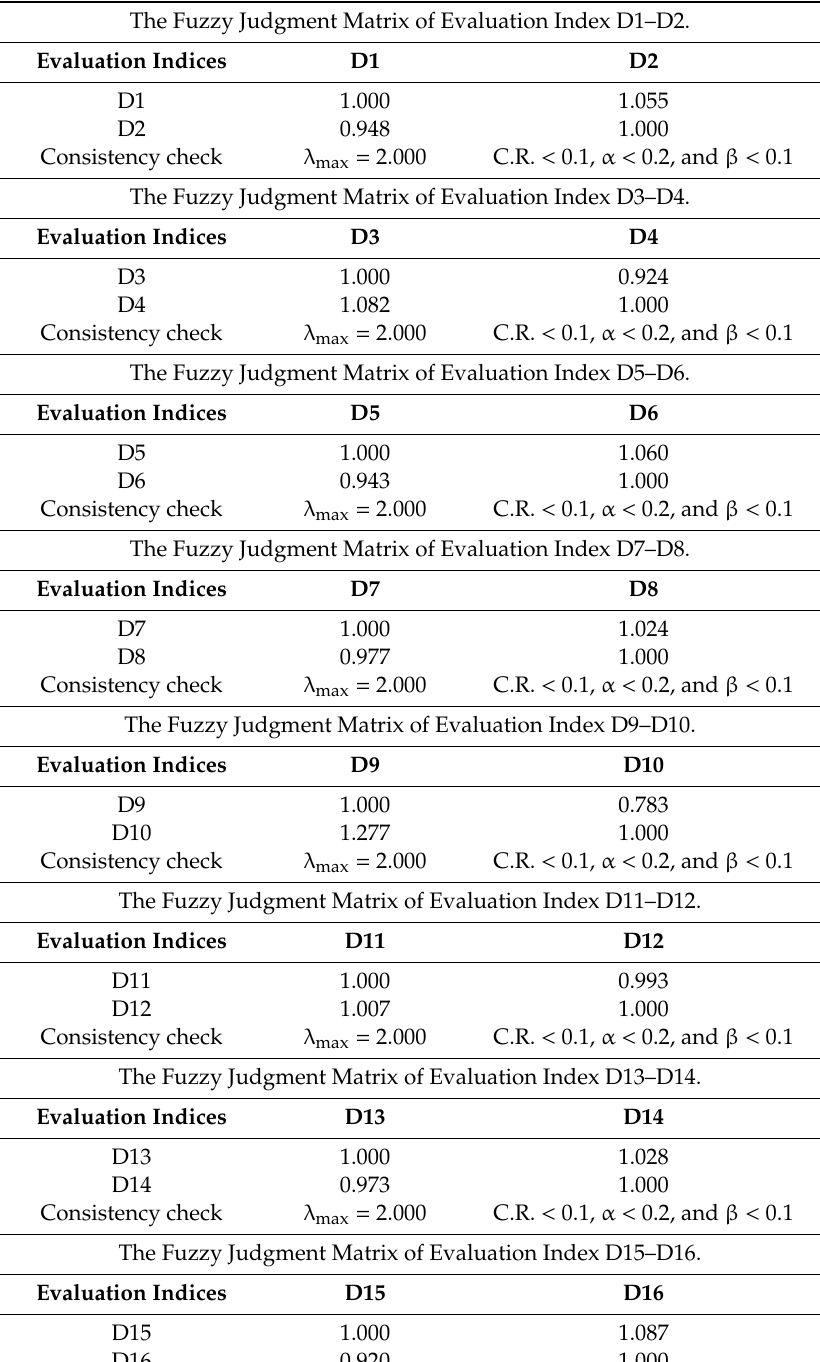
Table A4. The fuzzy judgment matrix of evaluation